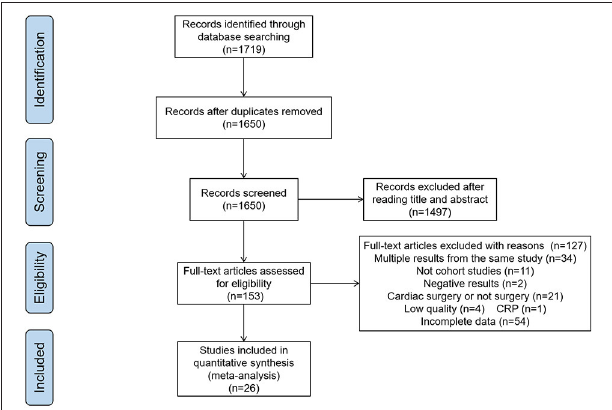
FIGURE 1 | The flow diagram of the